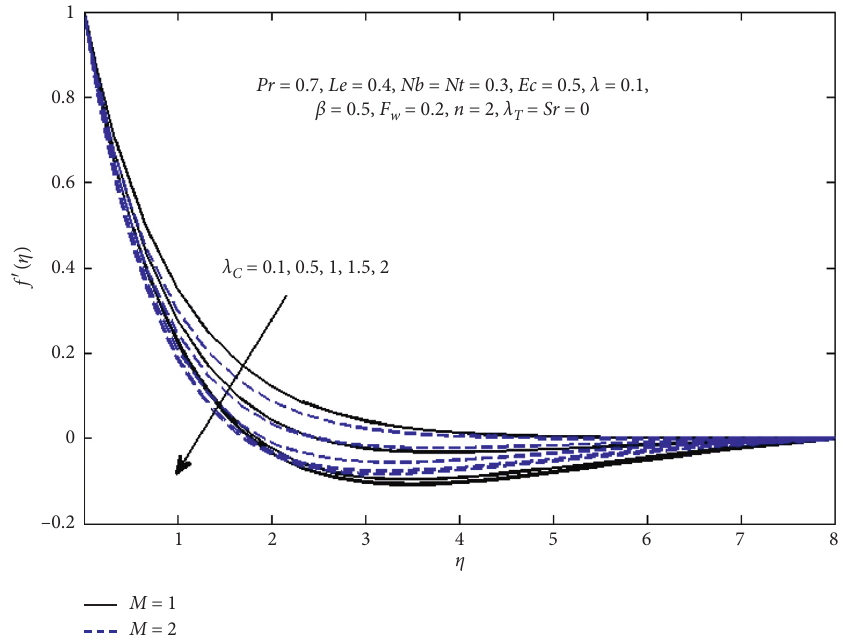
Figure 2: Variation of velocity f ′ concerning η with various values of λ